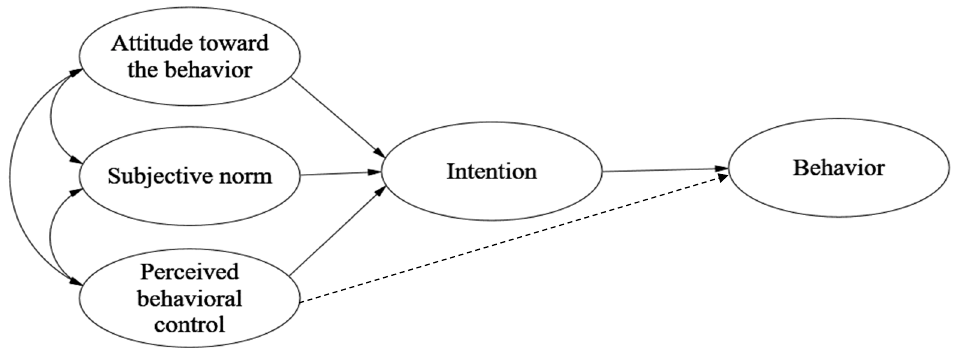
Figure 1. Theory of planned behavior. Source: Ajzen (1991, p. 182).